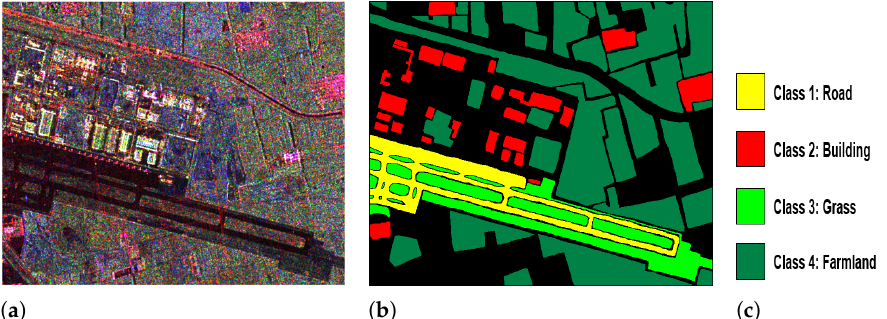
Figure 4. The Yihechang dataset. ( a ) Pauli RGB image; ( b ) ground truth; ( c ) color code of the different classes.